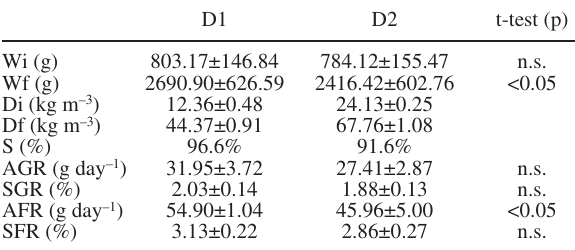
Table 2. – Mean values ± SD of every index for each experimental group in experiment 3 (effects of culture density). Wi, initial weight; Wf, final weight; Di, initial density; Df, final density; S, survival; AGR, absolute growth rate; SGR, specific growth rate; AFR, abso- lute feeding rate; SFR, specific feeding rate; n.s.= not significant.